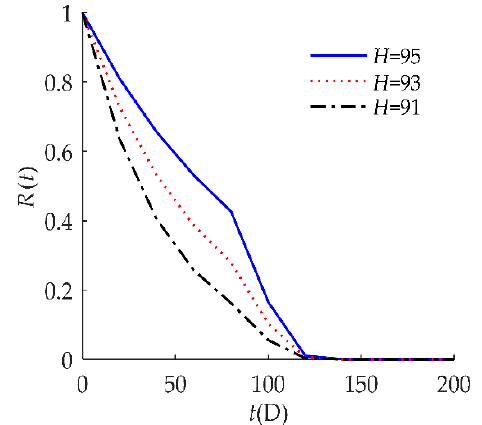
Figure 11. Sensitivity analysis of R ( t ) on D for example II.